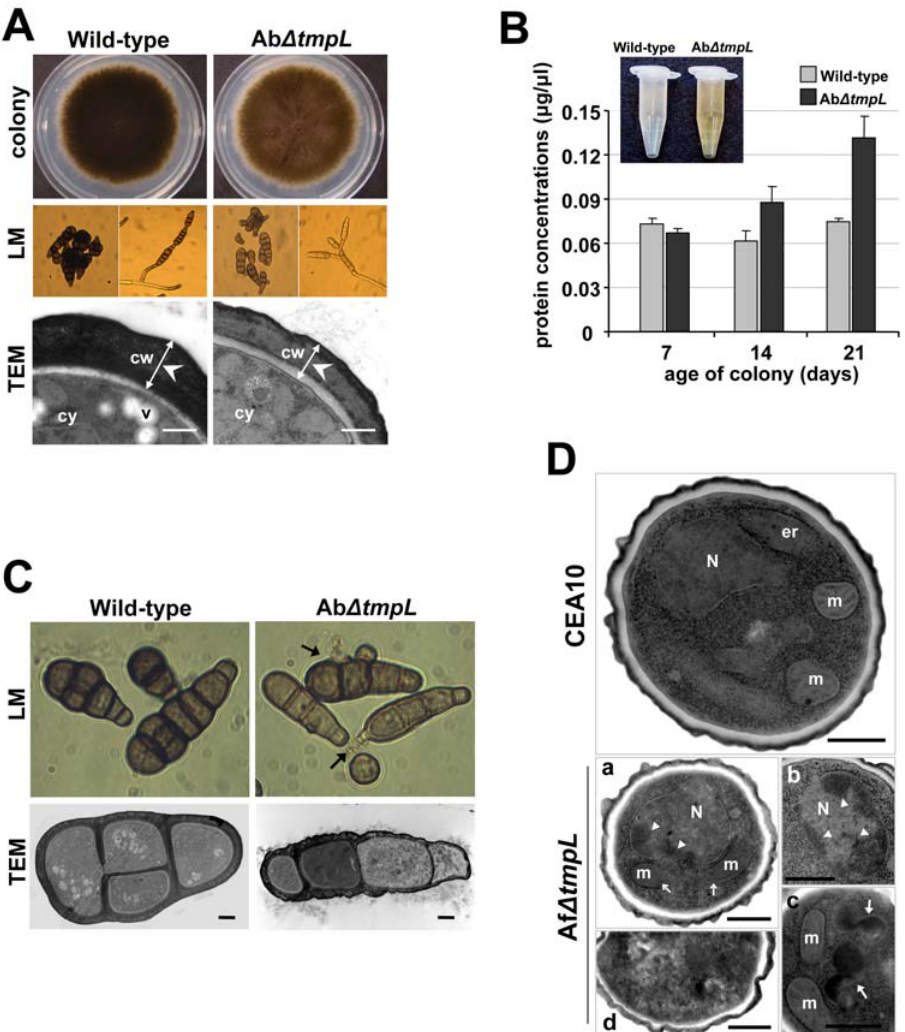
Figure 5. Abnormal conidiogenesis and rapid loss of cell integrity in aged conidia of the D tmpL mutants. ( A ) Fungal colony grown on solid CM plates (colony). Note that the A. brassicicola D tmpL mutant colony is a light brown compared with the dark brown color of the wild-type colony. Light micrographs (LM) of less-pigmented conidia and abnormal branching of the conidial chain of the Ab D tmpL mutants compared to the normal conidiogenesis ofthewild-type. Transmissionelectronmicrographs(TEM) depictingtheless electron-denseand thinner cell wall ofanAb D tmpL mutantconidium compared to a wild-type conidium. Bars=500 nm. Abbreviations: cw, conidial cell wall; cy, conidial cytoplasm; v, vacuole. ( B ) Quantification of protein concentration from conidial suspensions of A. brassicicola wild-type and D tmpL mutant. Note color difference of conidial suspensions between the wild-type and mutants (inset). Values indicate the total quantity of protein released by different-aged fungal cultures from each strain. Average values and SD of three independent quantitations are shown. ( C ) Light and transmission electron micrographs of 21-day-old conidia of A. brassicicola wild-type and D tmpL mutant. Arrows indicate cytoplasmic bleeding due to cell burst of the Ab D tmpL mutant conidia. Bars=2 m m. ( D ) Transmission electron micrographs showing sections of 10- day-old conidia of A. fumigatus wild-type CEA10 and D tmpL mutants. Compared to the normal nucleus and subcellular structures of the wild-type conidia, more than half of the Af D tmpL mutant conidia showed at least one of the apoptotic histological markers: (a) discontinuous or missing mitochondrial outer membrane,(b) chromatincondensationandmargination(arrowheads;aandb), (c) accumulationofhugeelectrondensematerials (arrows) incytoplasm,and (d) conidia with features of necrotic cell death. Bars=500 nm. Abbreviations: er, endoplasmic reticulum; m, mitochondria; N, nuclei.